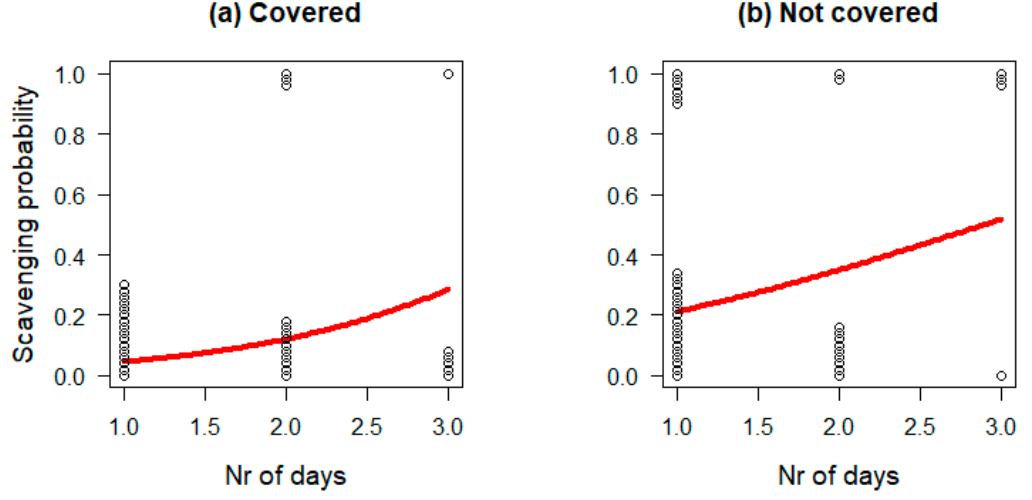
Figure 1. Logistic regression model curves explaining the probability of being scavenged in relation to the number of days since the kill was made for ( a ) covered and ( b ) not covered lynx-killed roe deer carcasses in South-Eastern Norway ( n = 74).